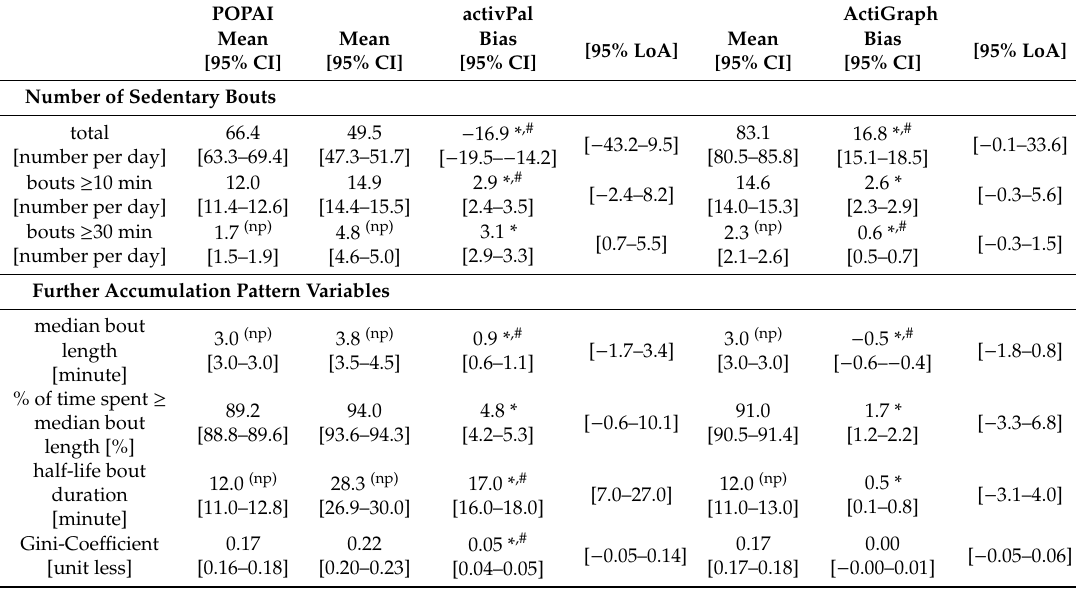
Table 2. Bland-Altman comparison of the sedentary accumulation pattern. Sedentary accumulation pattern for each method with activPal and ActiGraph bias and limit of agreement (LoA), n = 100. POPAI activPal ActiGraph Mean Mean [95% CI] [95%